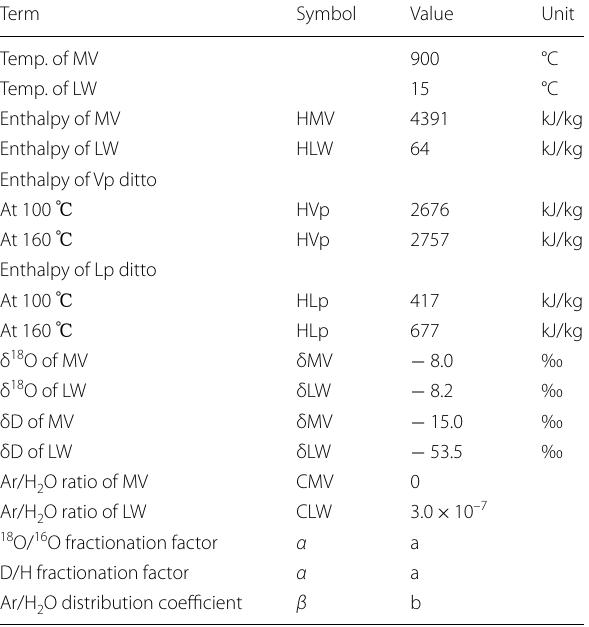
Table 2 Parameters for the calculation of the vapor and liquid